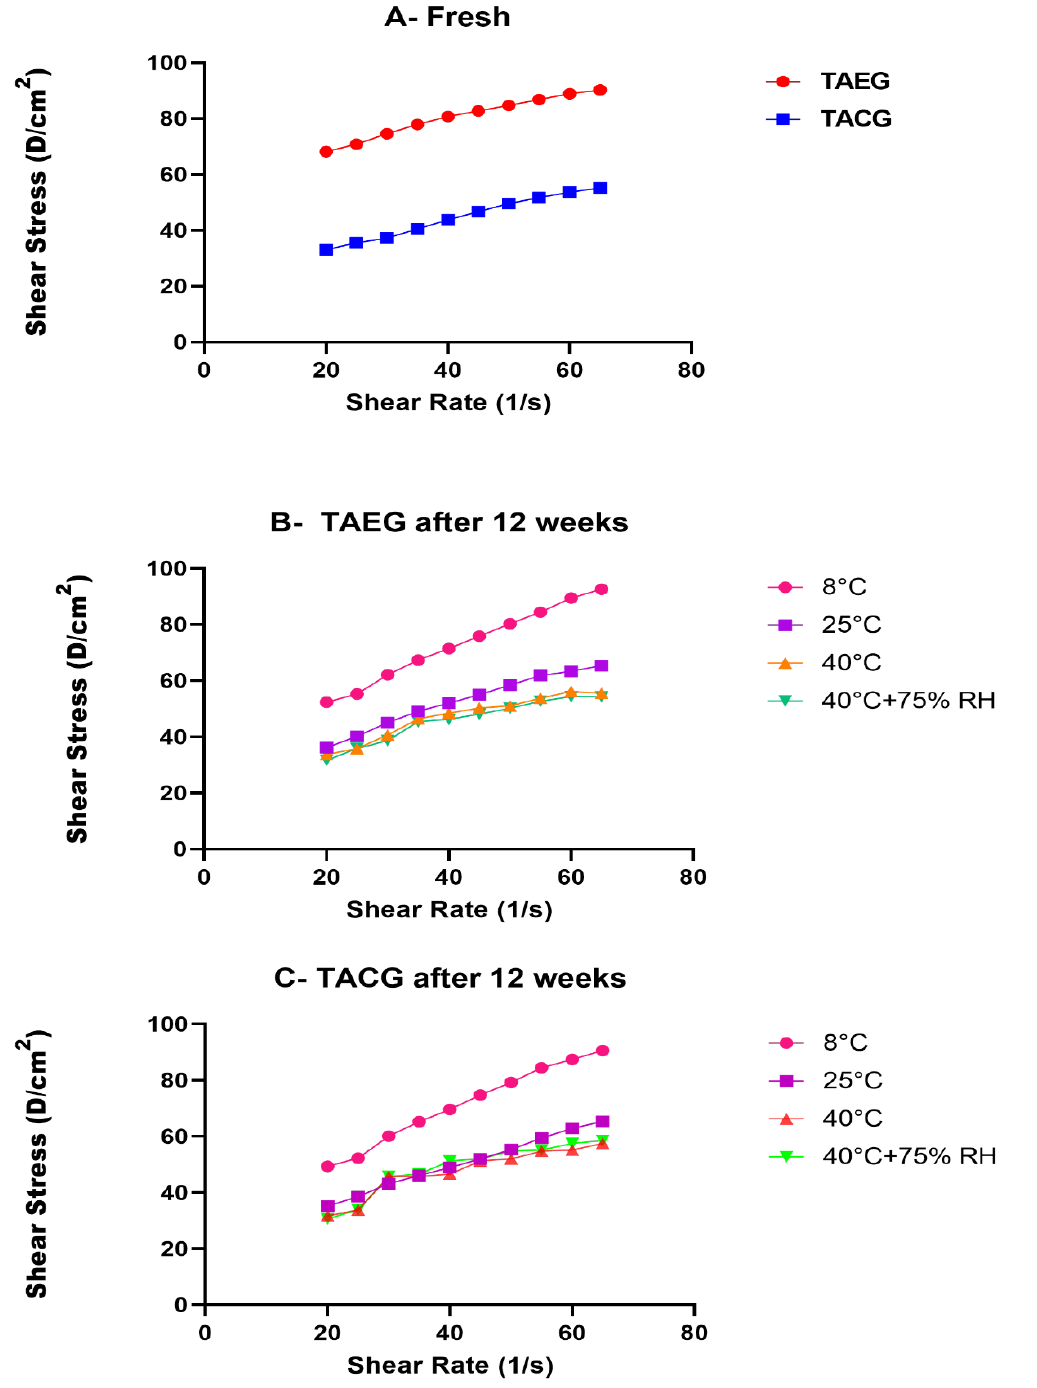
Figure 6. Rheological analysis of ( A ), Optimized TAEG (TA-5) and TACG freshly prepared at room temperature (25 ◦ C), ( B) , Optimized TAEG (TA-5) after 12 weeks, ( C) , TACG, after 12 weeks. The formulations were kept at different temperatures 8 ◦ C, 25 ◦ C, 40 ◦ C and 40 ◦ C ± 75% RH and at share rate of 1/s. Data are expressed as mean values ± SEM. Shear thinning effects were produced, but insignificant results are obtained once the study period is completed ( p > 0.05).